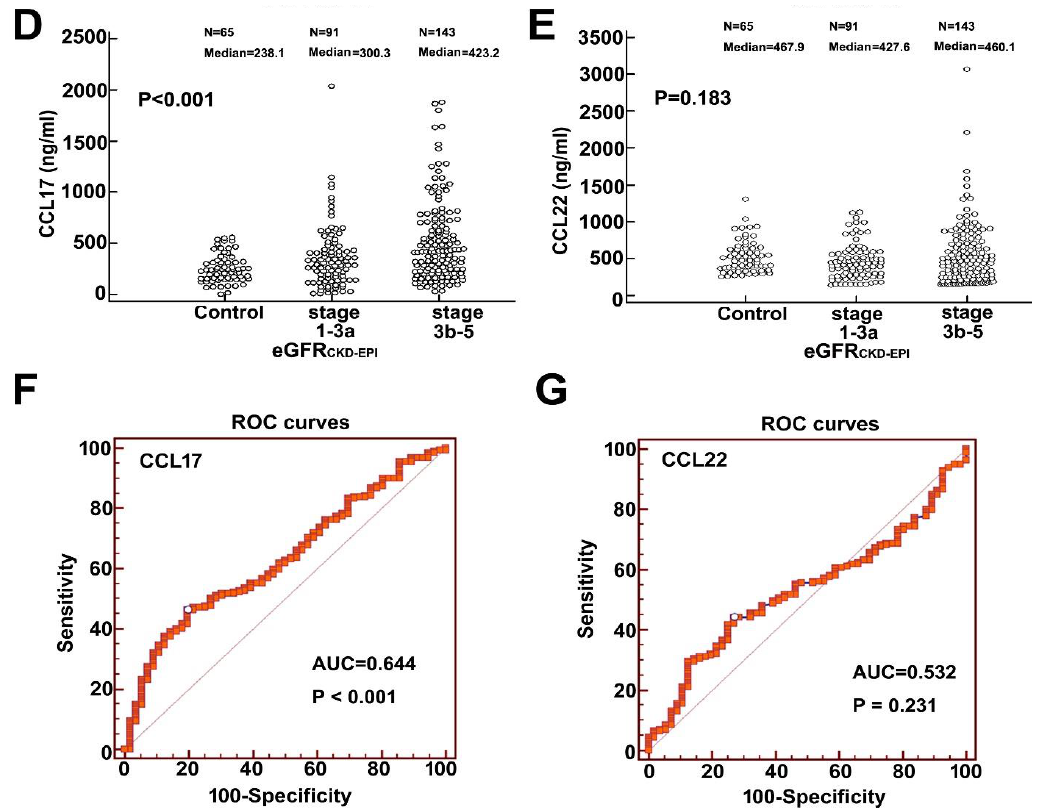
Figure 1. Increasing expression of CCL17 with decreasing renal function. ( A ) Human cytokine array profile of cell lysates from the normal population and patients with CKD stages 1, 3, and 5. CCL17 spots are marked. Correlation analysis of ( B ) CCL17 ( C ) or CCL22 with eGFR CKD-EPI for all CKD patients. Comparison of mean serum values of ( D ) CCL17 ( E ) and CCL22 between the normal population (control), CKD stages 1–3a and stages 3b–5. The area under the receiver operating characteristic curve indicated the diagnostic power of ( F ) CCL17 ( G ) and CCL22 for predicting advanced CKD (stages 3b–5). Table 1. Baseline characteristic of eGFR CKD-EPI for normal control, early CKD and advanced CKD patients. Early CKD Advanced